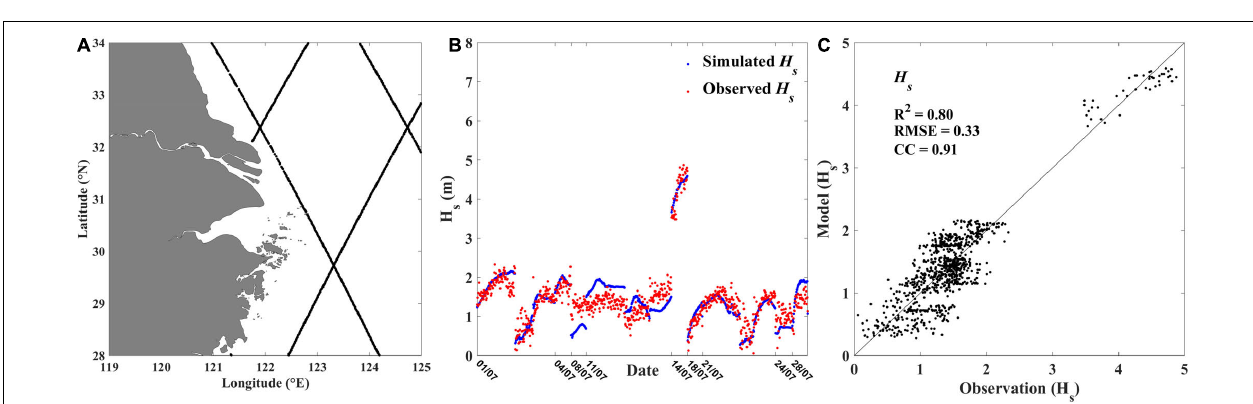
FIGURE 3 | The model result of the cross-sectional distribution of salinity corresponding to the observations in Wei et al. (2017) with (A) along 32.3 ◦ N during July 18 and 19, (B) along 32.7 ◦ N during July 19 and 20, (C) along 33.0 ◦ N on July 20, and (D) along 33.3 ◦ N on July 21.